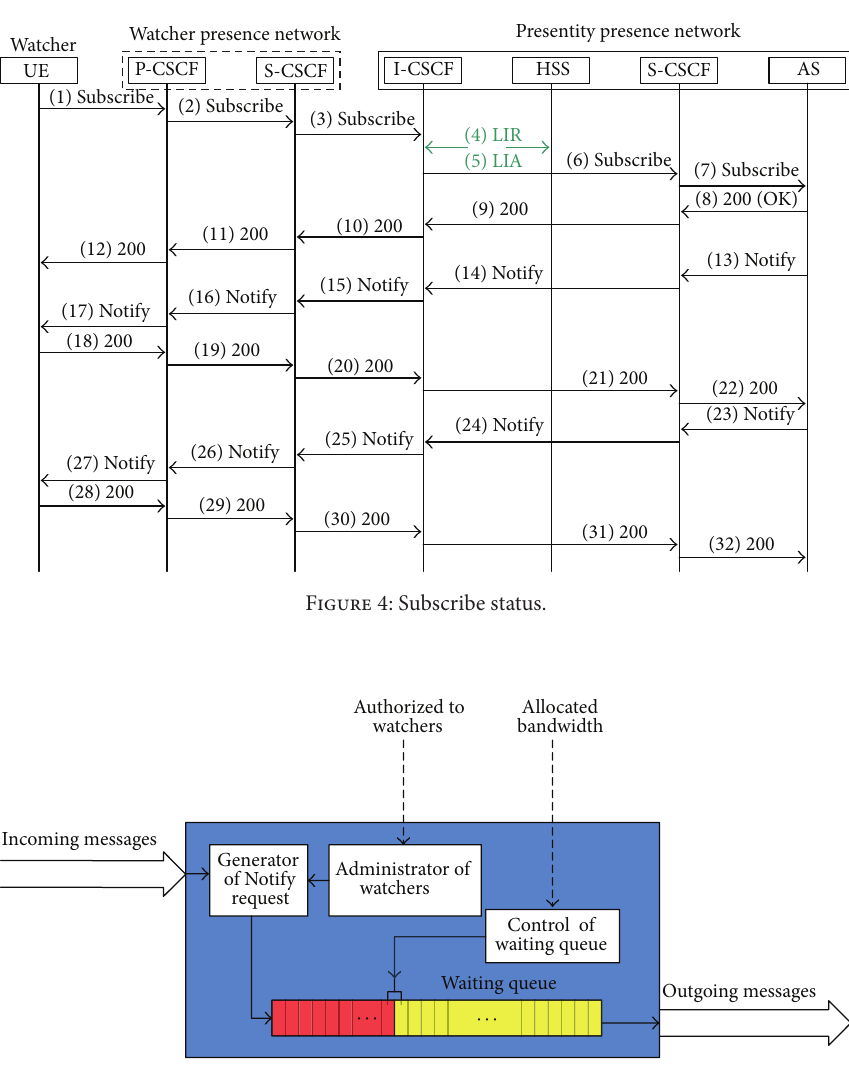
Figure 5: Logical scheme of the presence